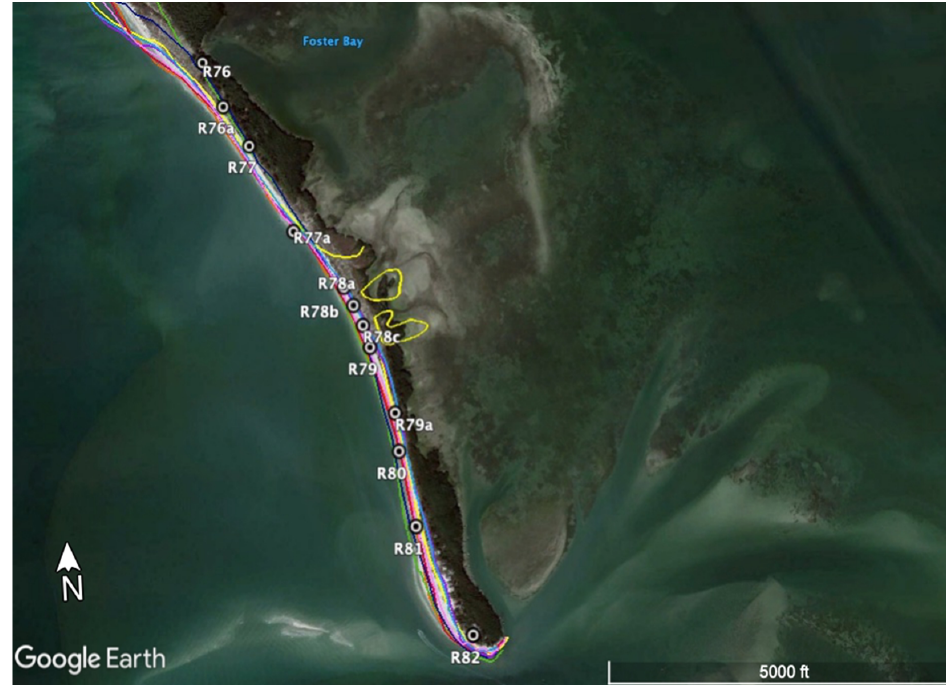
Figure 2. Google Earth image of North Captiva Island, depicting coastline from 1994–2019, denoted by different colored paths. R-monuments are overlaid on map, R67–R82.